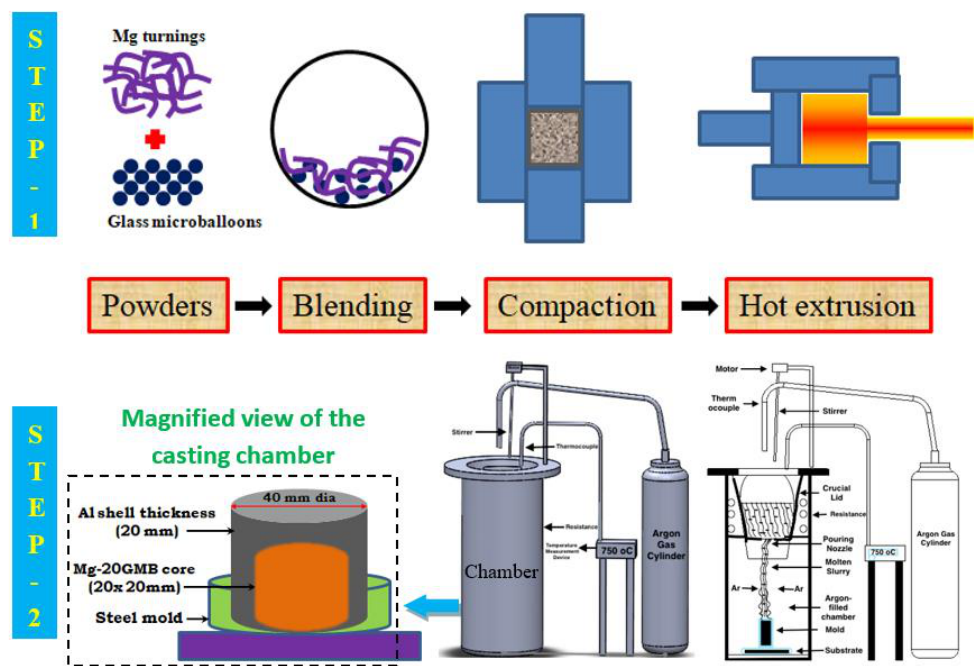
Figure 2. Schematic of fabricating the hybrid composite. Step-1: Synthesis of Mg-20GMB syntactic composite core material. Step-2: Fabrication of as-cast Al / Mg-20GMB composite by DMD method.